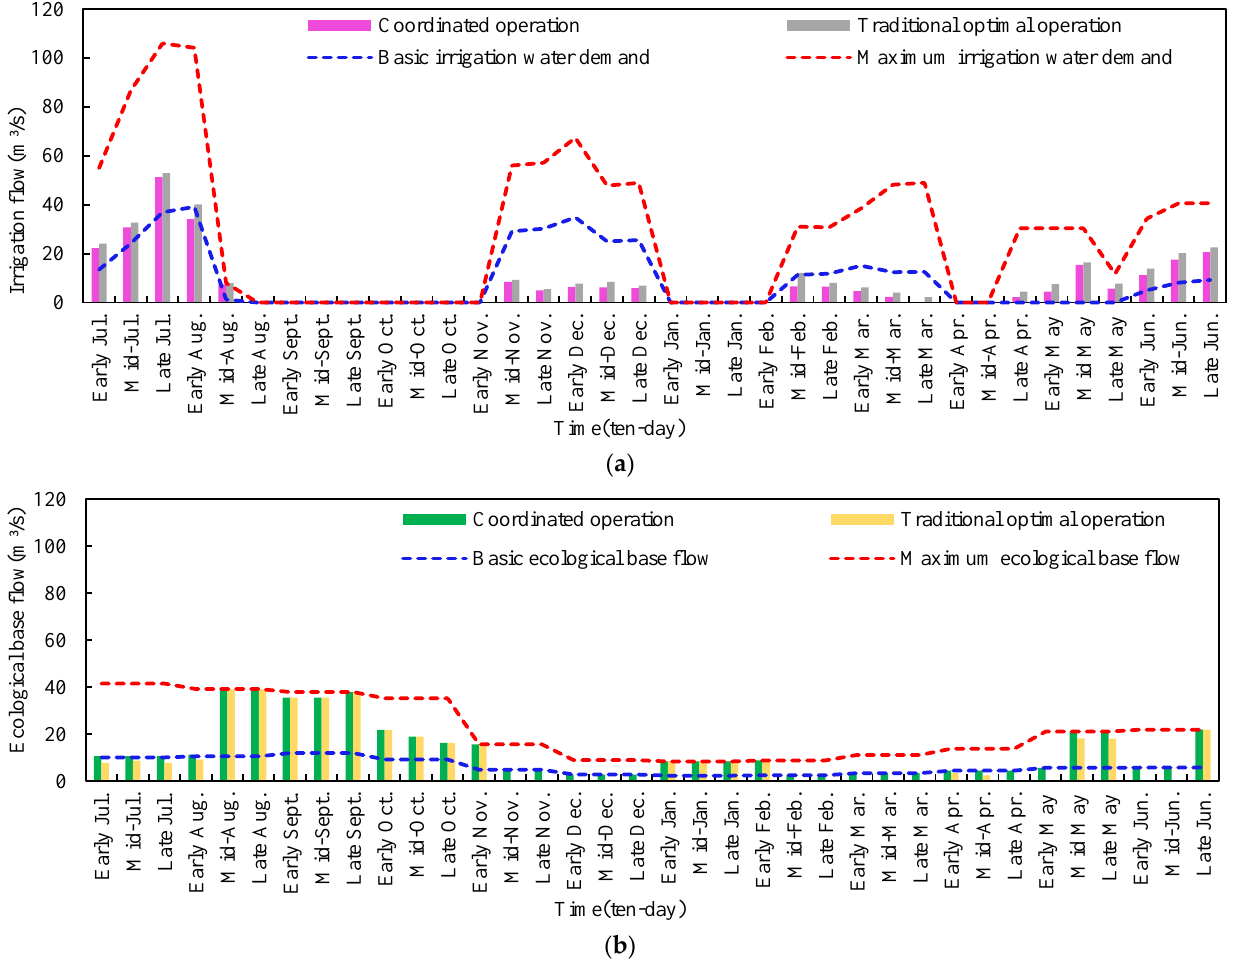
Figure 9. Irrigation and ecological water supply processes of two operation methods in an extraordinary dry year: ( a ) irrigation; ( b ) ecology.